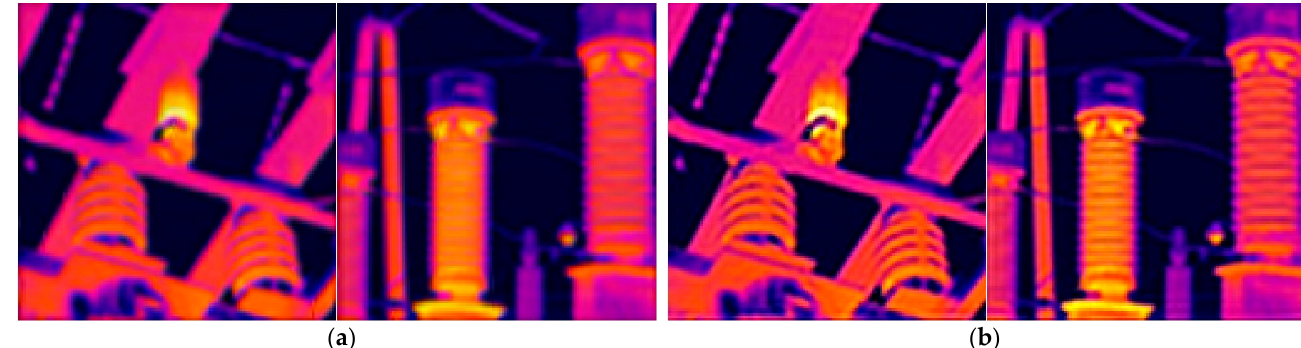
Figure 8. The influence of blur matrix on reconstruction effect: ( a ) infrared images reconstructed by the traditional CS method without a blur matrix; ( b ) infrared images reconstructed by our method of introducing the blur matrix into the reconstruction model.